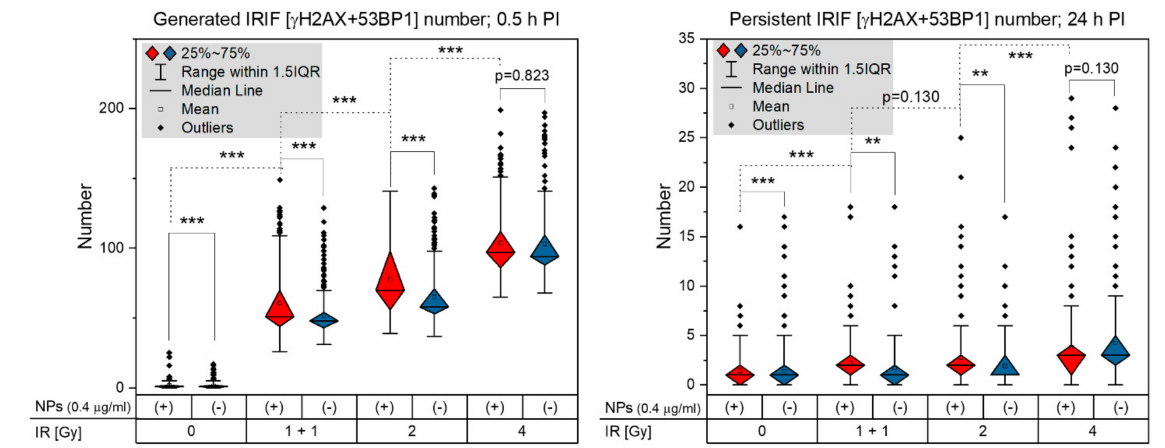
Figure 3. Numbers of generated ( left graph) and persistent DSBs ( right graph) as a function of radiation dose and presence of GNPs. DSBs were quantified as colocalized [ γ H2AX+53BP1] repair foci. The average numbers of [ γ H2AX+53BP1] repair foci per nucleus are shown together with 1.5 IQR (interquartile range) for SkBr3 breast cancer cells exposed to 1 + 1, 2 or 4 Gy γ -ray doses in the presence (+) or absence ( − ) of 10 nm GNP (0.4 µ g/mL). The cells were fixed at 0.5 h (left graph) or 24 h PI (right graph). The shorter time corresponds to the post-irradiation period with the maximal occurrence of repair foci while the longer time corresponds to the post-irradiation period when the vast majority of DSBs is repaired. Rhombuses contain 50% of dataset values, which lay between the top (75%) and bottom (25%) quartiles. Asterisks denote statistical significance of differences between indicated samples at p = 0.05 (*), p = 0.01 (**) or p = 0.001 (***). Two-tailed t -test, two-tailed t -test with Welsh correction or Mann-Whitney Rank Sum Test was used depending on the distribution normality of the analyzed